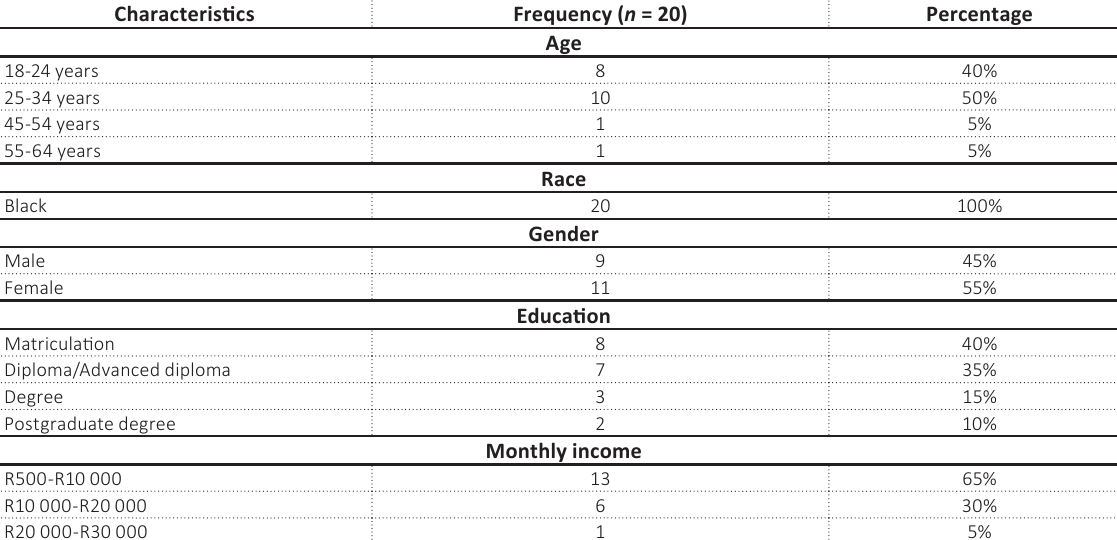
Table 1. Socio-demographic characteristics and profiles of the participants Characteristics